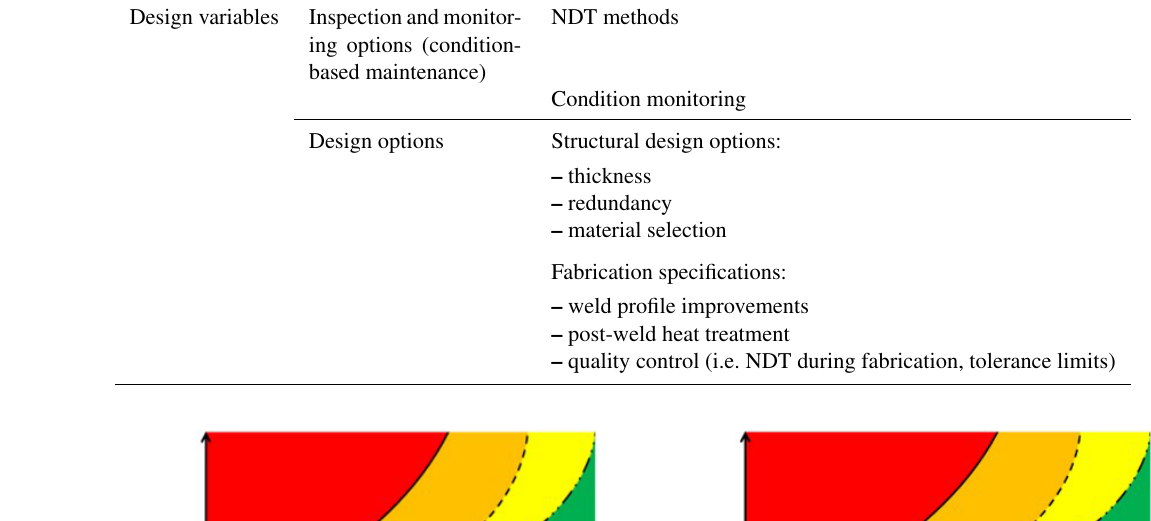
Table 3. Design variables for damage-tolerant fracture mechanics design.